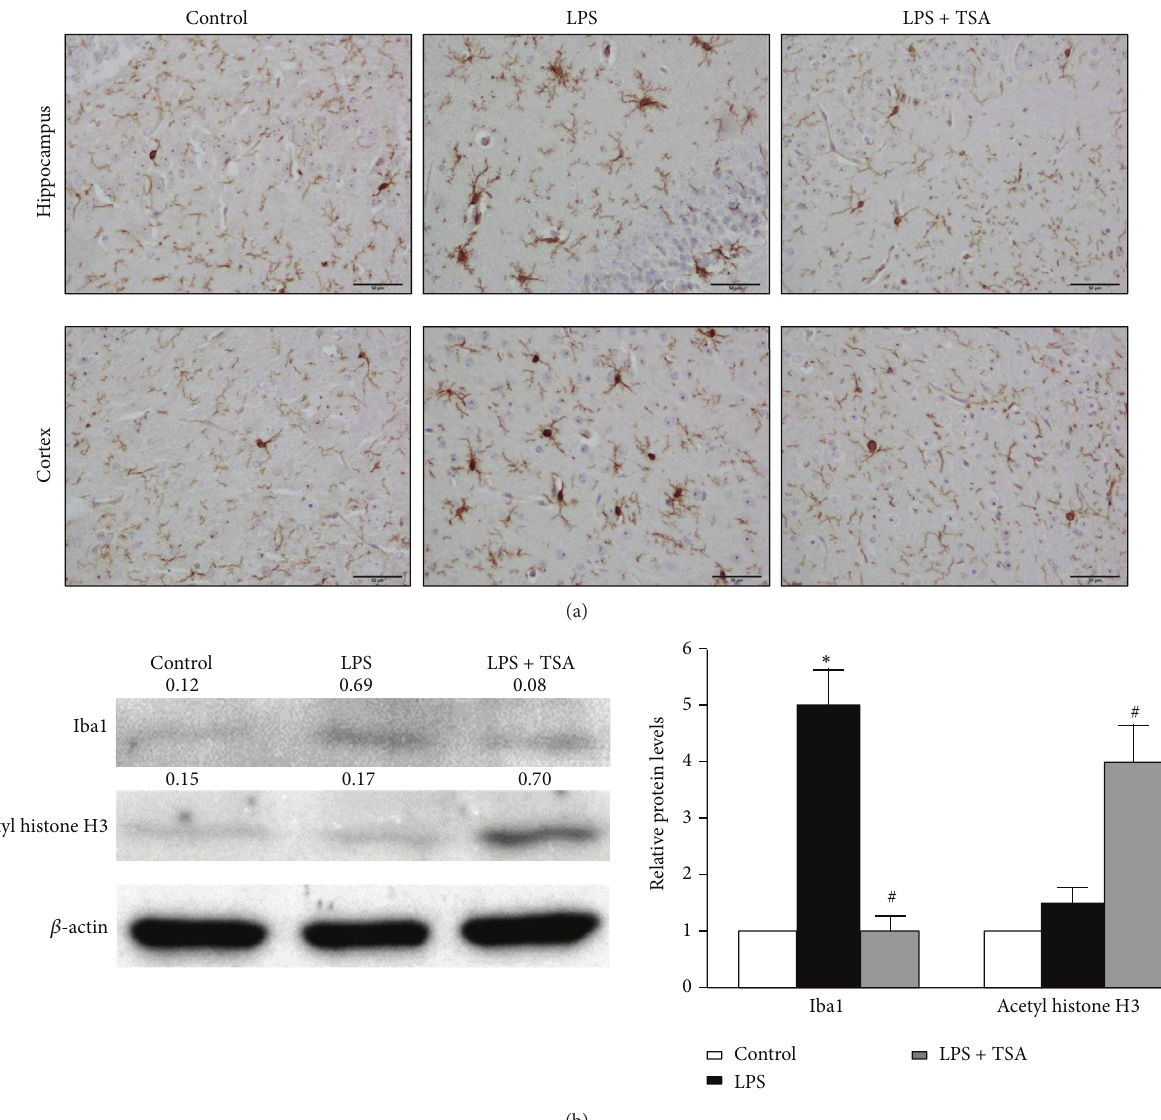
Figure 5: TSA reduced the LPS-induced activation of microglial cells in mice and BV-12 cells. (a) Mice were pretreated with saline (Controls) or TSA (0.3 mg/kg) for 1h and then intraperitoneally challenged with saline or E. coli LPS (1mg/kg). Immunohistochemistry staining shows that Iba1 expression in the hippocampus and the cortex of mice was higher after 24 h of LPS challenge than in Control and LPS + TSA mice. (b) One hour after BV-2 cells had been pretreated with TSA (10ng/mL), they were treated with LPS. Four hours later, the protein was collected. Western blotting shows Iba1 and acetyl histone H3 expression in BV-2 cells. The right panel shows the quantification of protein expression from three independent experiments. ∗ 𝑃 < 0.05 compared with the Control group; # 𝑃 < 0.05 compared with the LPS-only